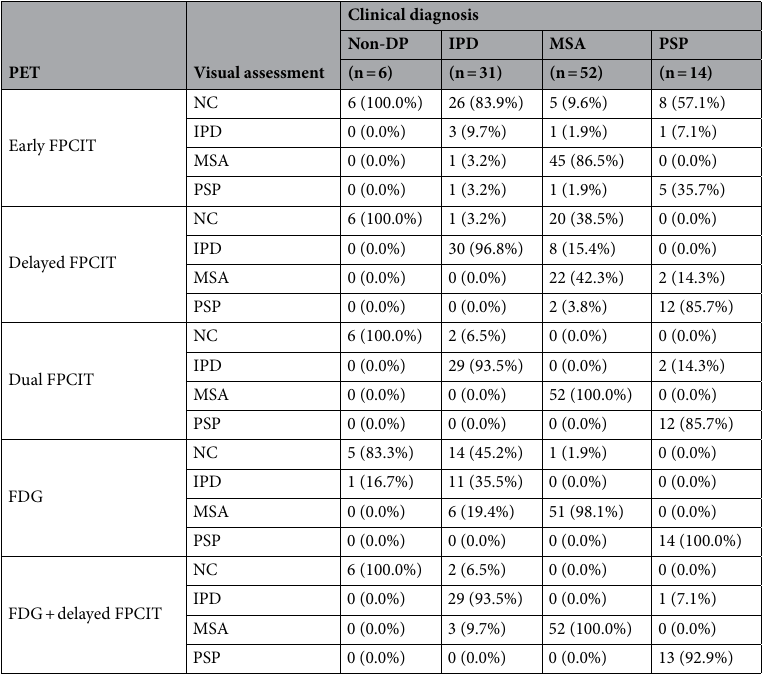
Table 3. Classification matrix of visual assessment of PET scans compared to clinical diagnosis in subjects followed for more than 1 year after PET scan.